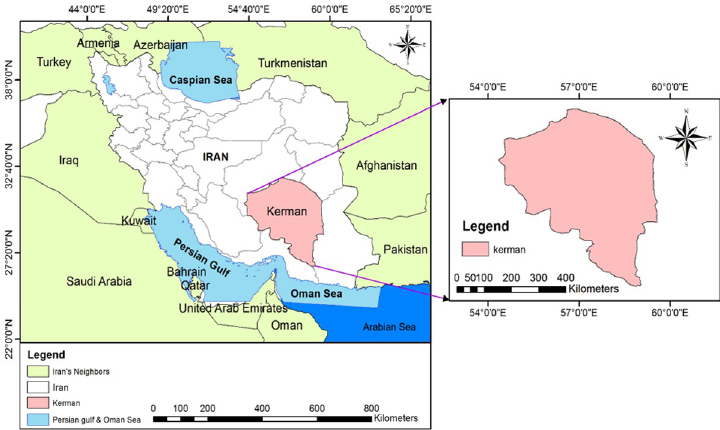
Fig 1. Geographical location of the study area, the Kerman province, Iran. The main data has been prepared in shapefile (shp) format from